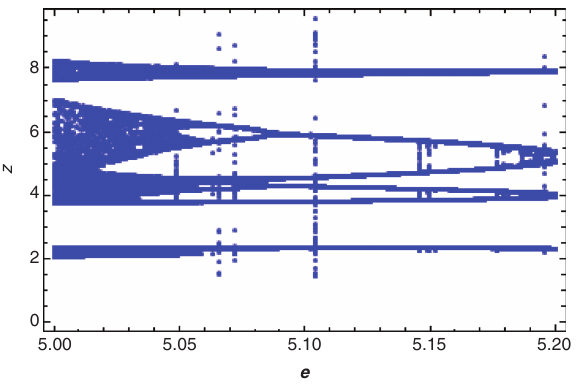
Figure 3: Z Bifurcation Diagram for Increasing e , and Showing Limit Cycle Period Doubling.